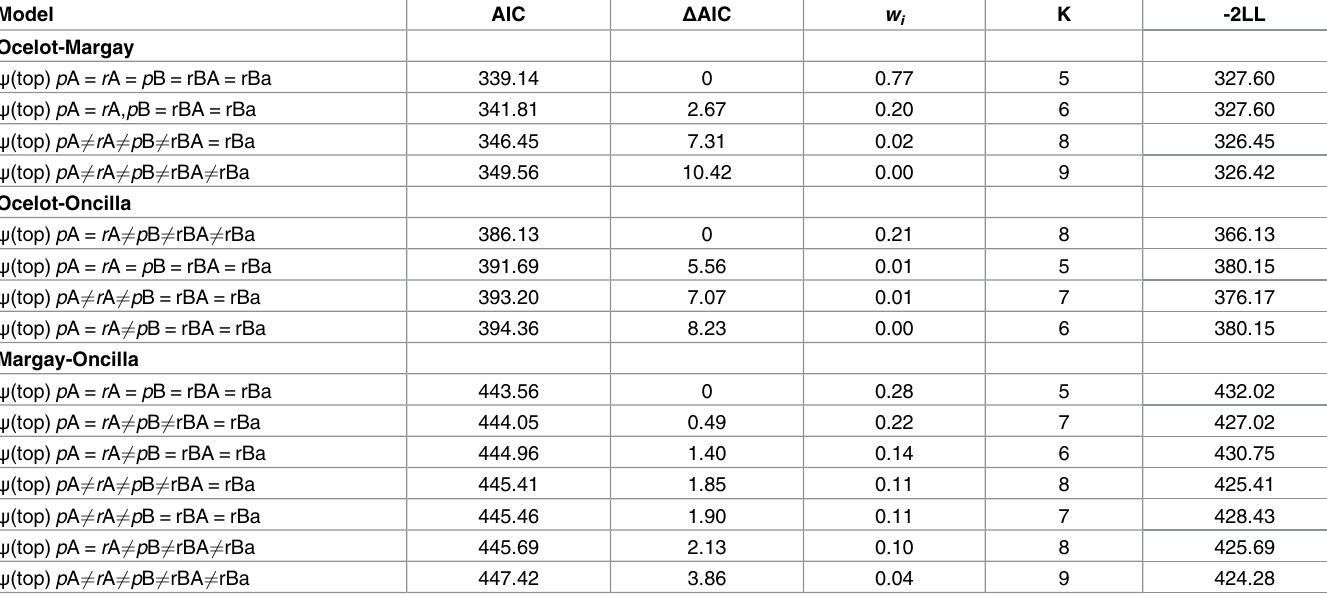
Table 4. Co-occurrence occupancy models used to evaluate the role of interspecific interactions on the detection probability of three sympatric Neotropical spotted cats in a large Atlantic Forest remnant. Model